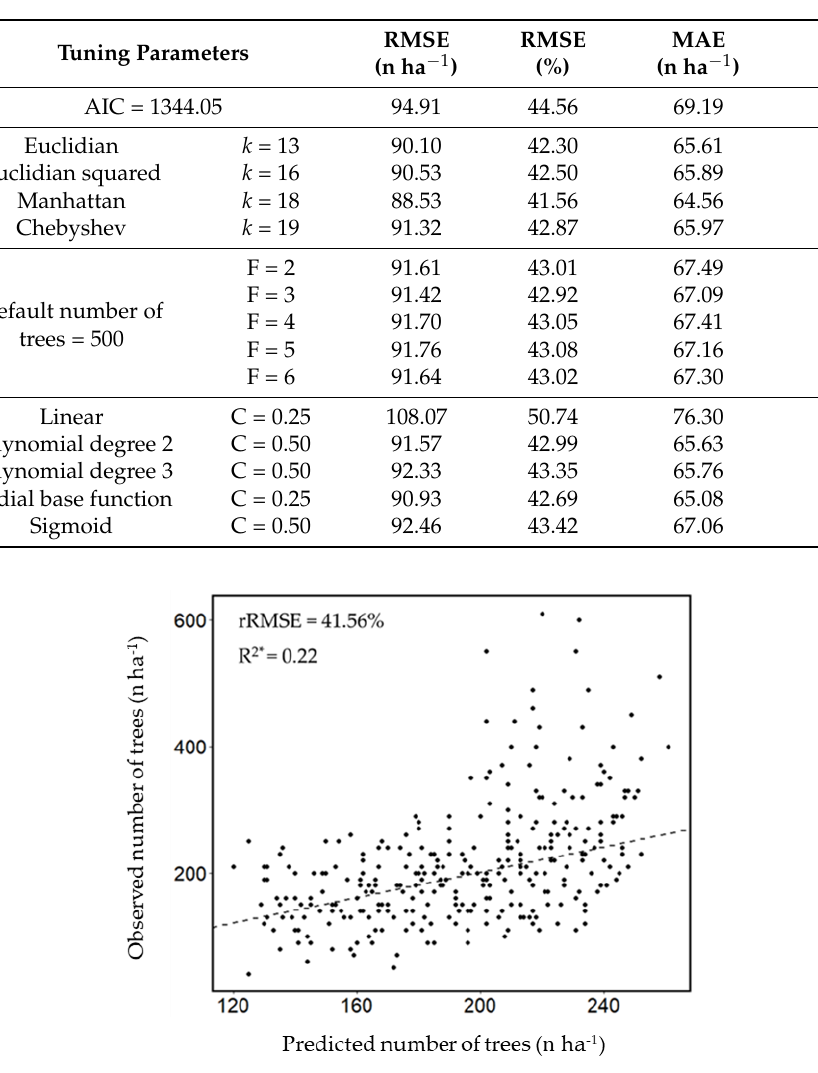
Figure 5. Scatter plot of observed versus the predicted number of trees ( N ) using the k -NN algorithm. The dashed line represents a 1:1